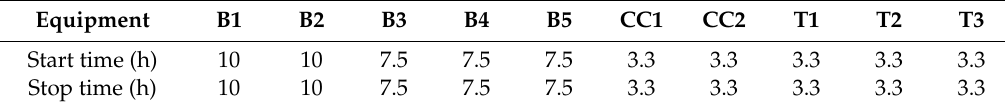
Table 7. Start and stop time of equipment.